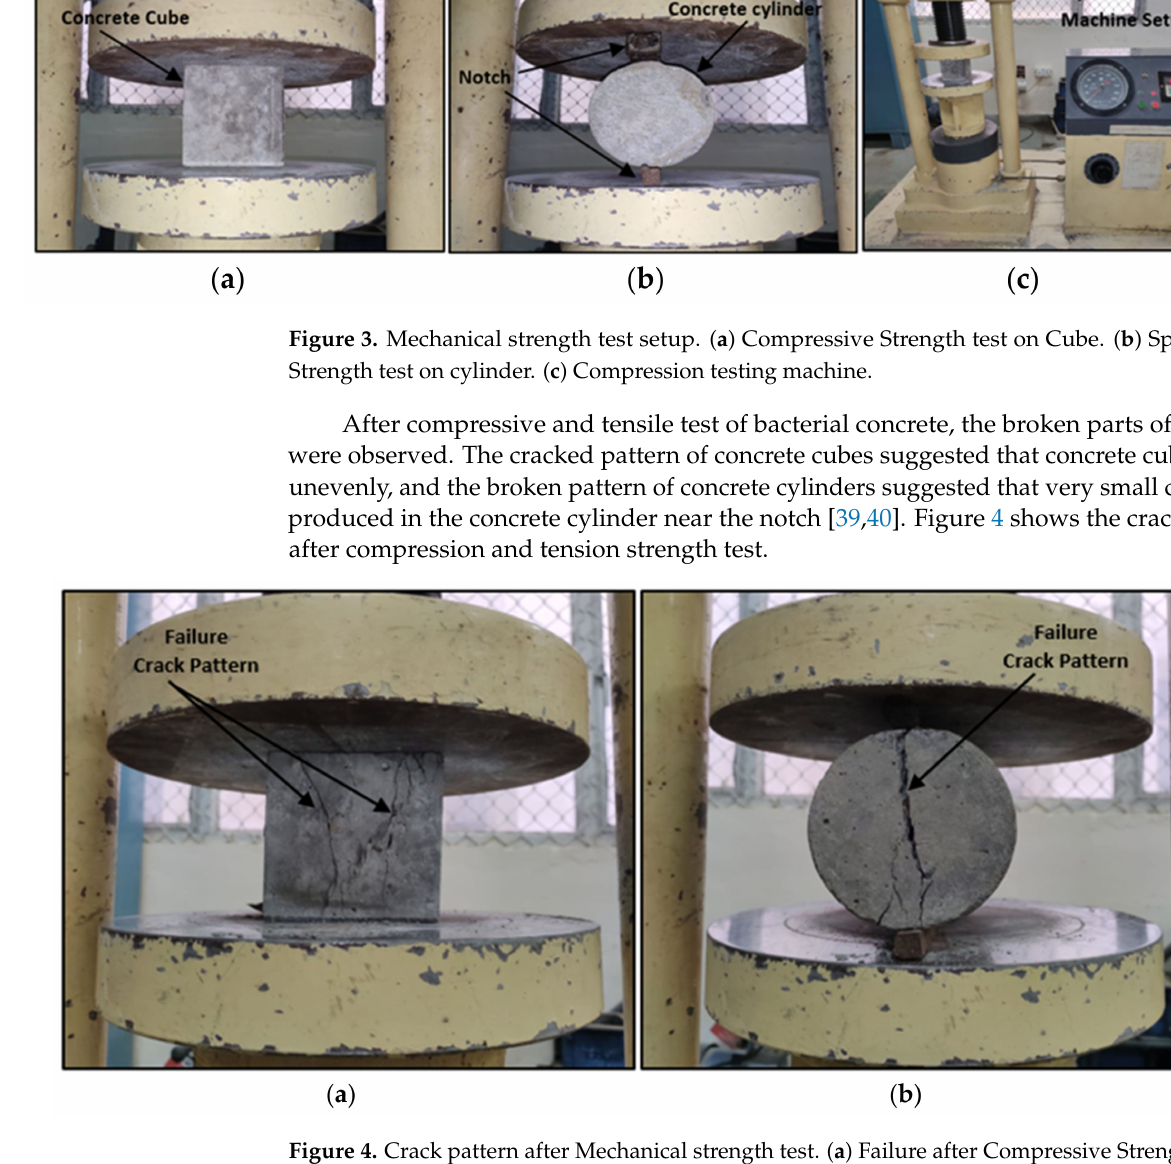
Figure 4. Crack pattern after Mechanical strength test. ( a ) Failure after Compressive Strength test on Cube. ( b ) Failure after Split Tensile Strength test on